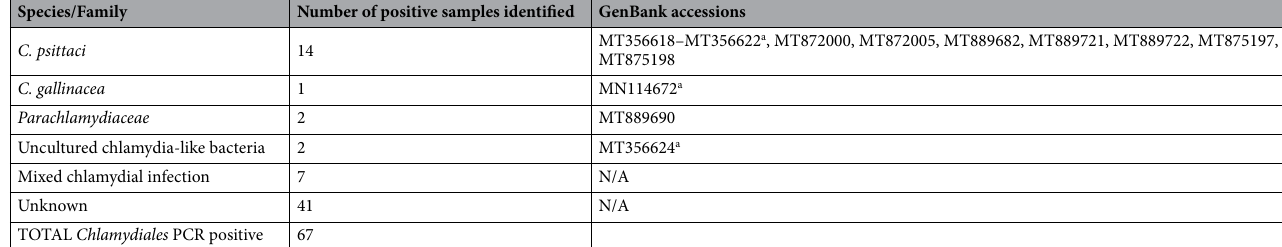
Table 1. Number of samples which tested positive for Chlamydiales by PCR, and sample identity as determined by species-specific PCR analyses and sequencing. a Denotes sequences obtained in previous studies 41,42